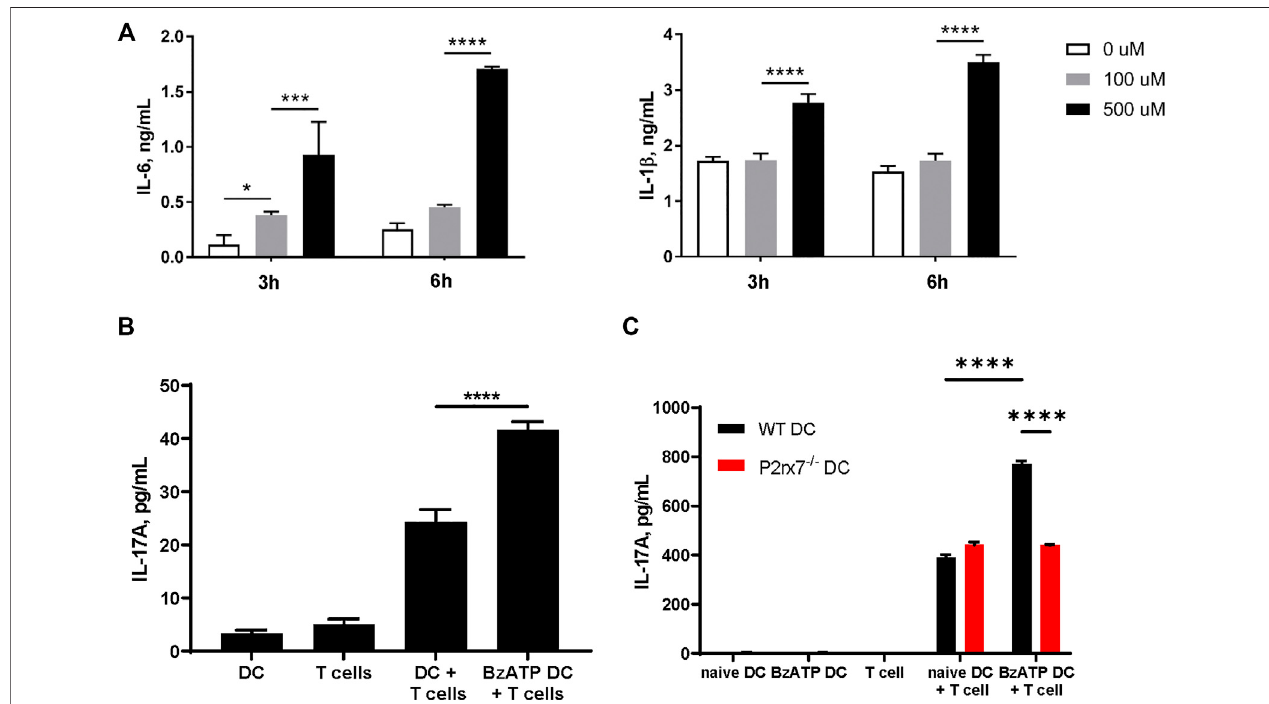
FIGURE 2 | Stimulation of P2X7R on DCs can promote IL-17 production in vitro . (A) Mouse BMDCs derived from C57BL/6J mice were stimulated with the indicated doses of BzATP and supernatants were collected 3 and 6 h later to determine IL-6 and IL-1 β production by ELISA. (B) Mixed leucocyte reactions (MLR) were inducedbyco-culturingnaiveCD4 + TcellsisolatedfromBALB/cJandBMDCsderivedfromC57BL/6Jmice,pretreatedwithBzATP(300 µM)orleftuntreated(controls) for 4 days. Supernatants were collected and L-17A levels assessed by ELISA. (C) BMDCs derived from WT or P2rx7 − / − mice, pretreated with BzATP or left untreated (controls), were cocultured with naive CD4 + T cells from BALB/cJ for 4 days. Supernatants were collected to assess IL-17A levels by ELISA. Results expressedasthemean±SEMfromonerepresentativeofthreeindependentexperiments.Foreachexperimentisolatedcellsfromseveralmicewerepooled,co-cultures were run in triplicate wells, and the ELISA was performed in duplicates for each well. * p < 0.05, *** p < 0.001, **** p < 0.0001; NS, not signi fi cant.